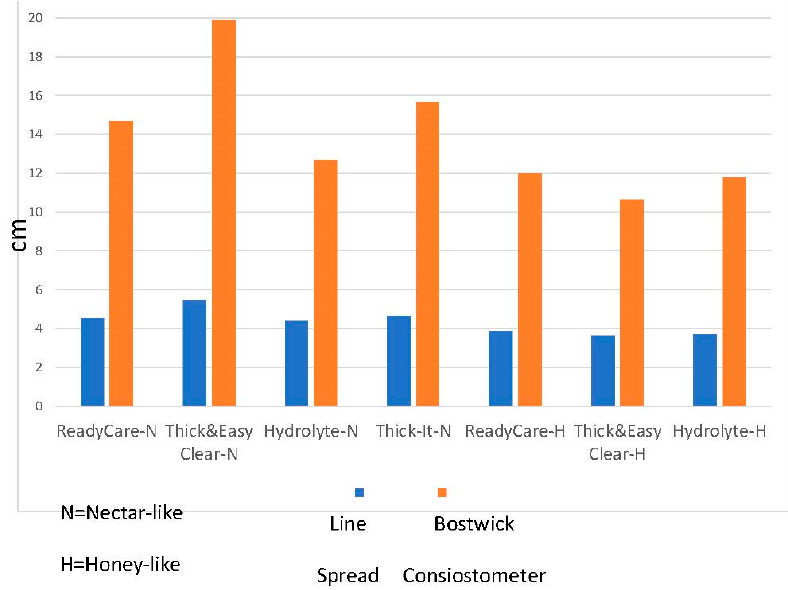
Figure 4. Physical Measures and Fliow (cm) for Line Spread and Bostwick.